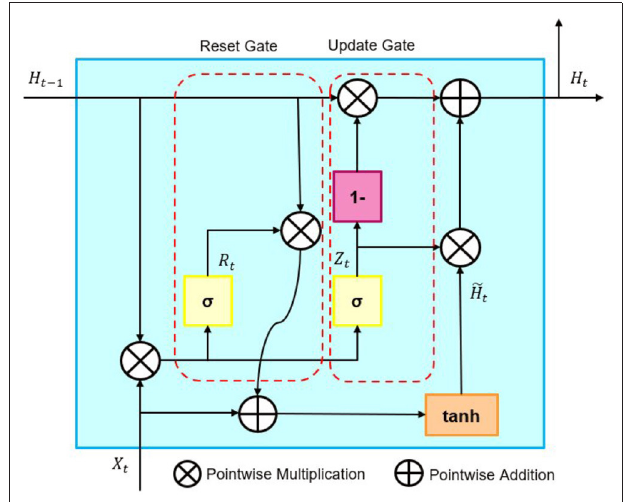
FIGURE 2 | Architecture of